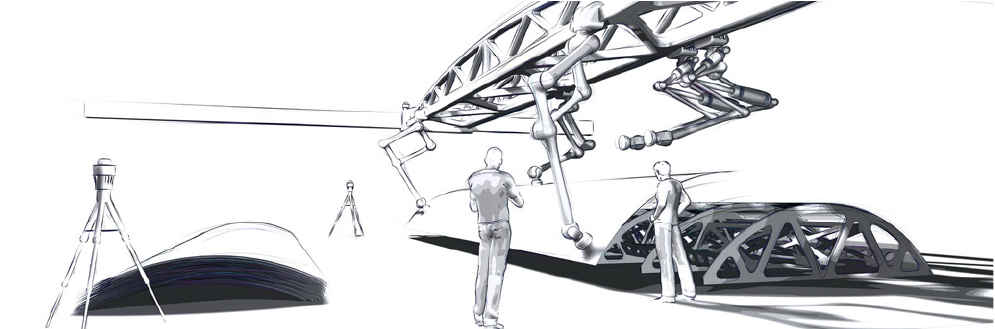
Figure 1. Design concept of the adaptable and reconfigurable handling system PARAGRIP.